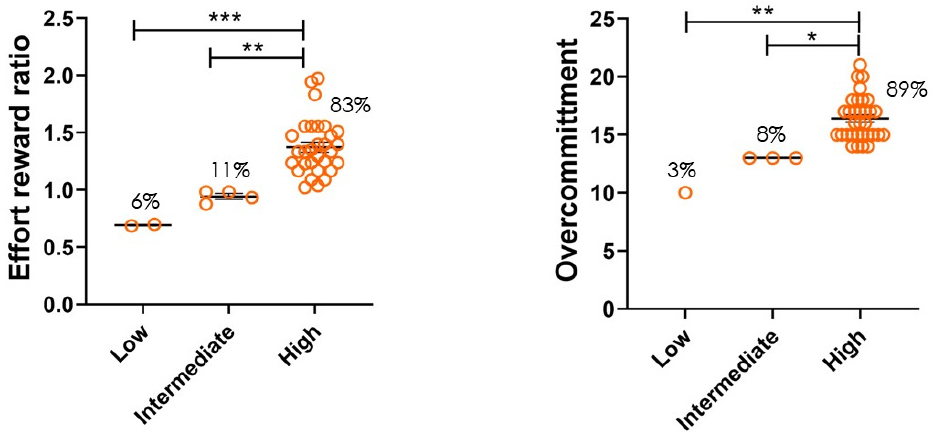
Figure 4. ERR and OC scores among emergency medical service professionals. Participants filled out survey questionnaires based on the effort–reward imbalance model. Job stress indicators: ERR and OC scores were calculated. ERR and OC scores were divided into low, intermediate, and high ranges calculated from the participant survey. High ERR scores were observed in 83% of participants, and high OC scores were observed in 89% of participants. *** p < 0.001, ** p < 0.01, * p < 0.05. Difference in ERR Low to High group is highly significant (*** p < 0.001) and ERR Intermediate to High group is also significantly different (** p < 0.01) as shown in graph, Significant difference is also found in OC Low to High and OC Intermediate to High group.